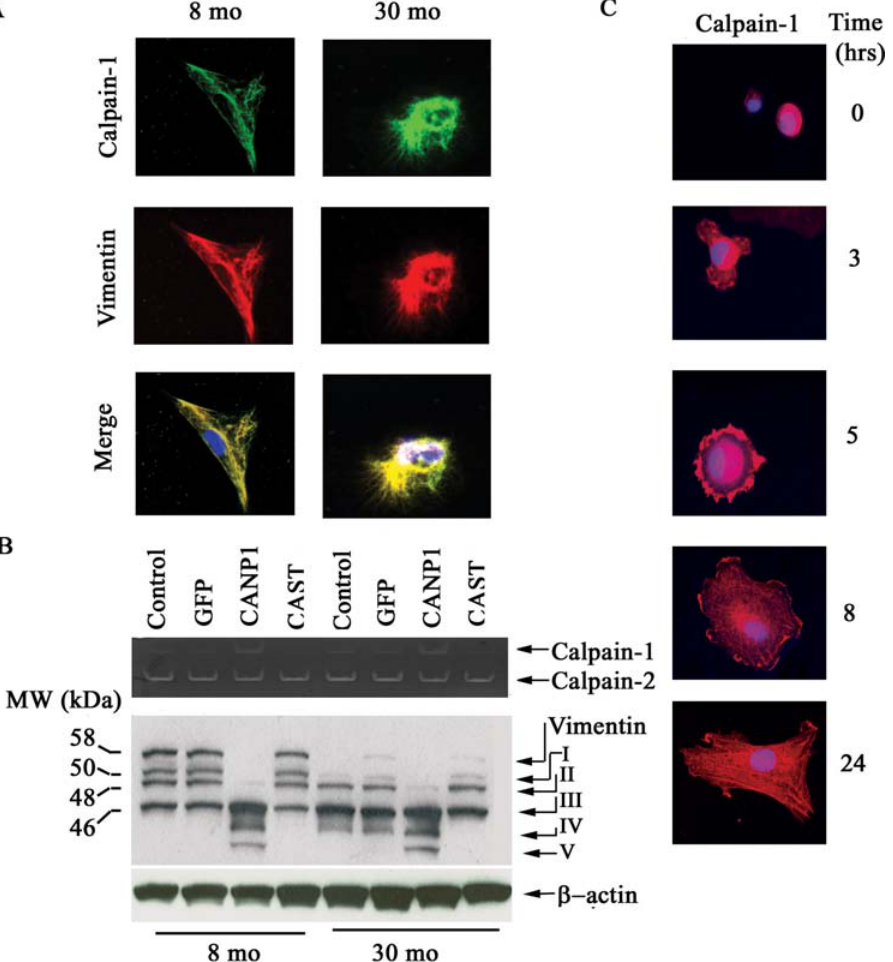
Figure 6. Calpain-1 and vimentin interactions within VSMC. A. Photomicrographs of dual labeling for calpain-1 (green) and vimentin (red) within VSMC from young (left panels) and old rats (right panels); merged image (yellow bottom panels). B. Casein zymogram of VSMC from young and old VSMC infected with a CANP1 or CAST virus (upper panel). Western blots of vimentin from young and old VSMC infected with CANP1 or CAST virus (lower panel). Proteolytic fragments are indicated by arrows and designated I-V. C. Fluorescence labeled calpain-1 protein of VSMC isolated from young rat aortae. VSMC were isolated from the aorta of 8-month-old rat, allowed to adhere on a fibrogen matrix, fixed with methanol and acetone, and stained with calpain-1 antibody (red). The nuclei were counterstained with DAPI (blue). Magnification 6